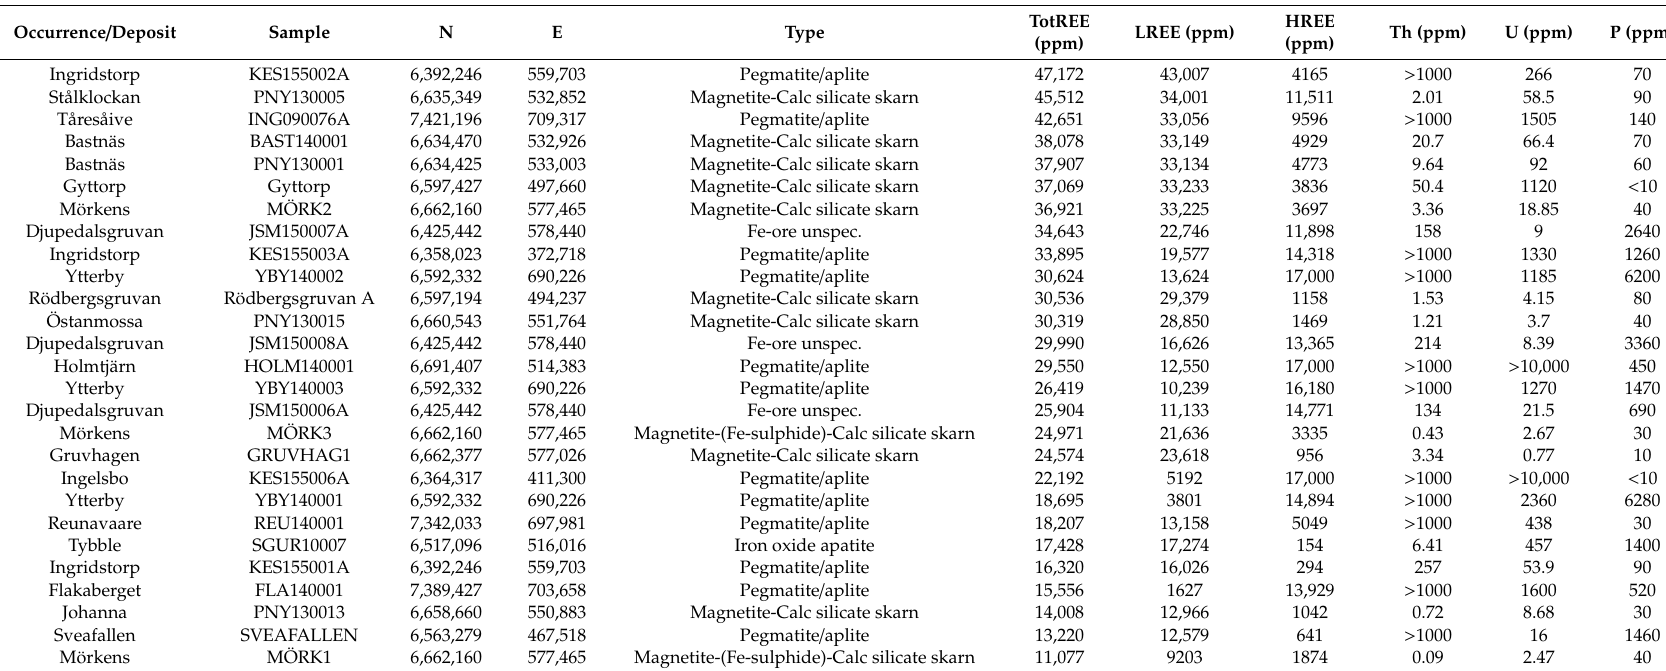
Table 1. Summary of samples analyzed with a total REE (TotREE) content above 1% (10,000 ppm). N and E are SwerefTM